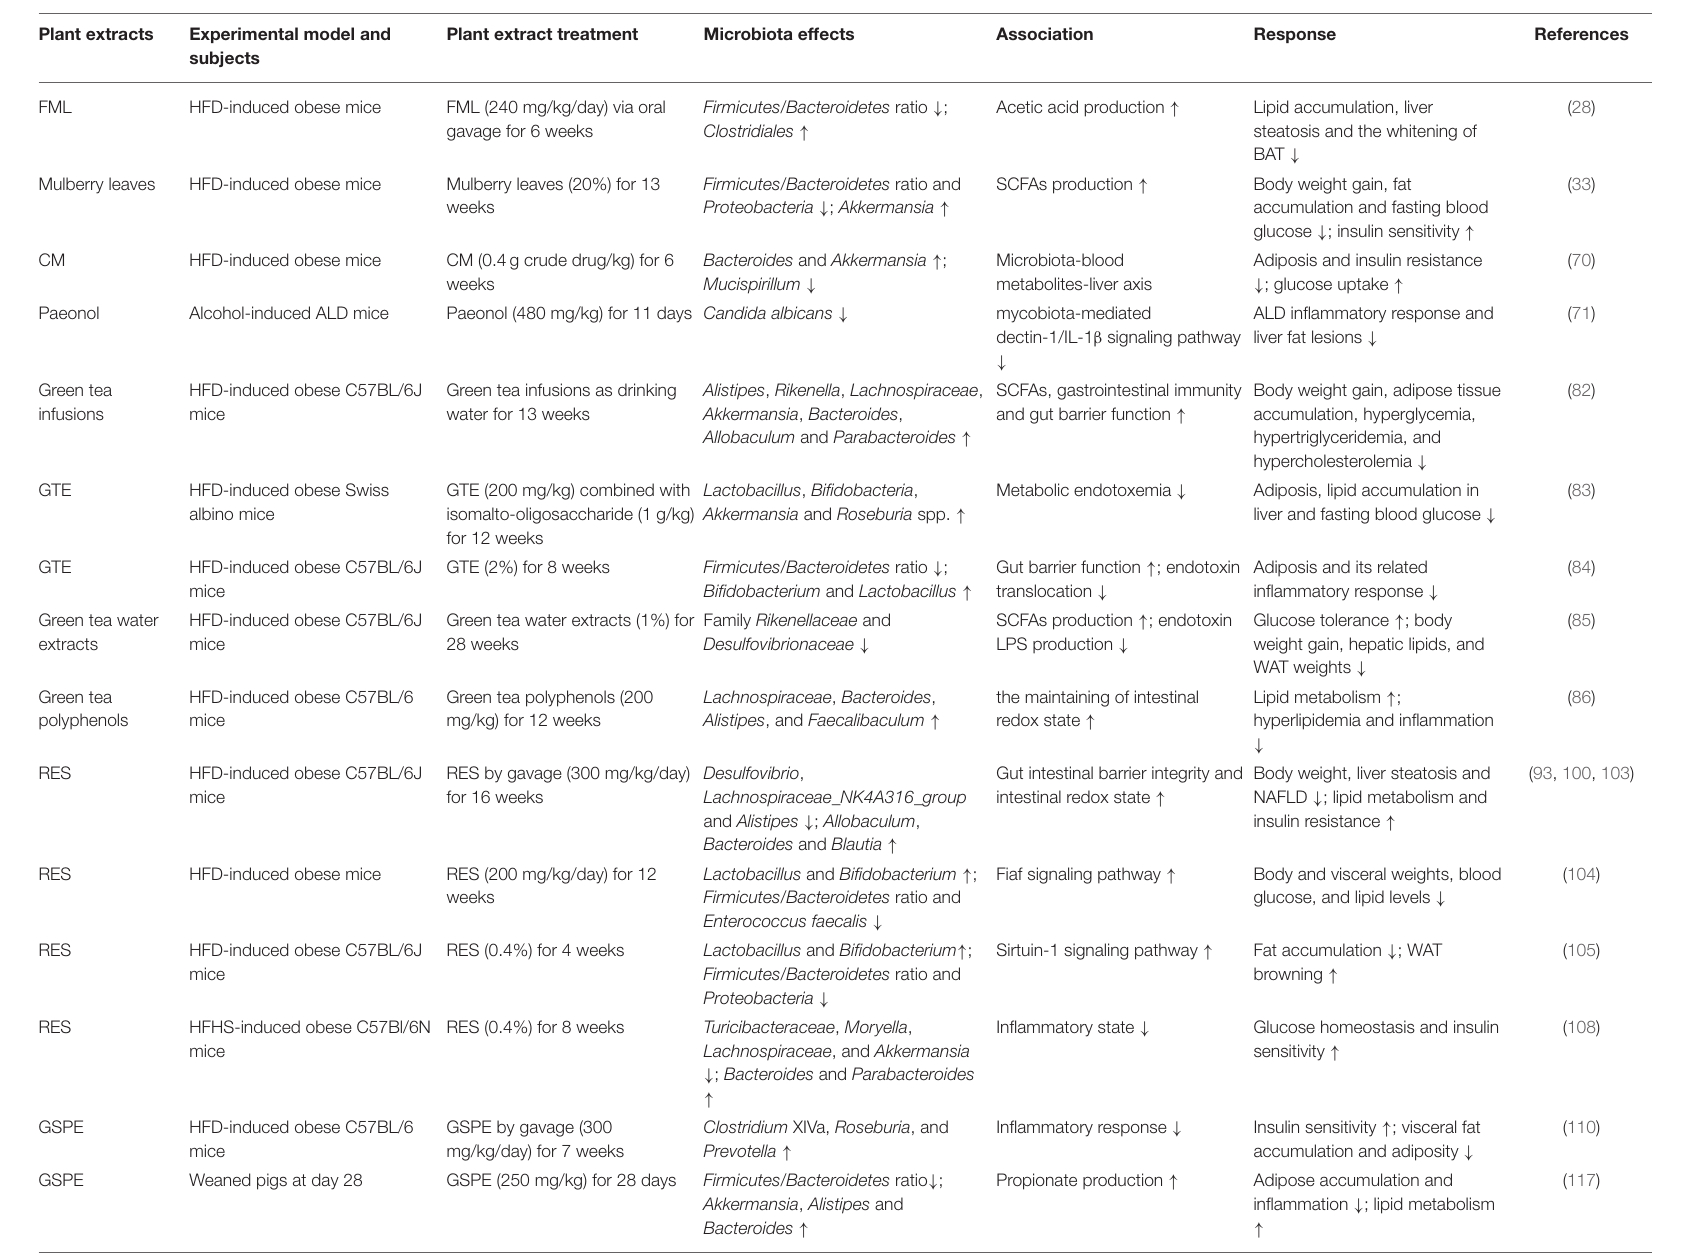
TABLE 1 | Summary of the effects of plant extracts on gut microbiota, obesity and its related metabolic disorder. Plant